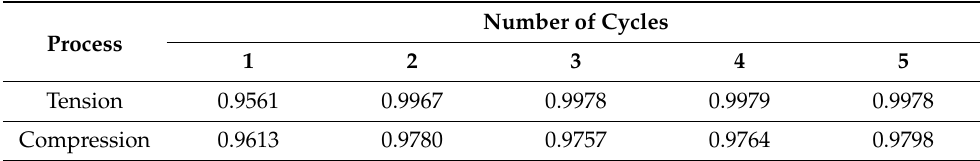
Figure 12. Model prediction of different cycles during the cyclic compression process of the high- damping rubber material. Table 3. Values of R 2 for each loading-unloading cycle during the cyclic tension and compression